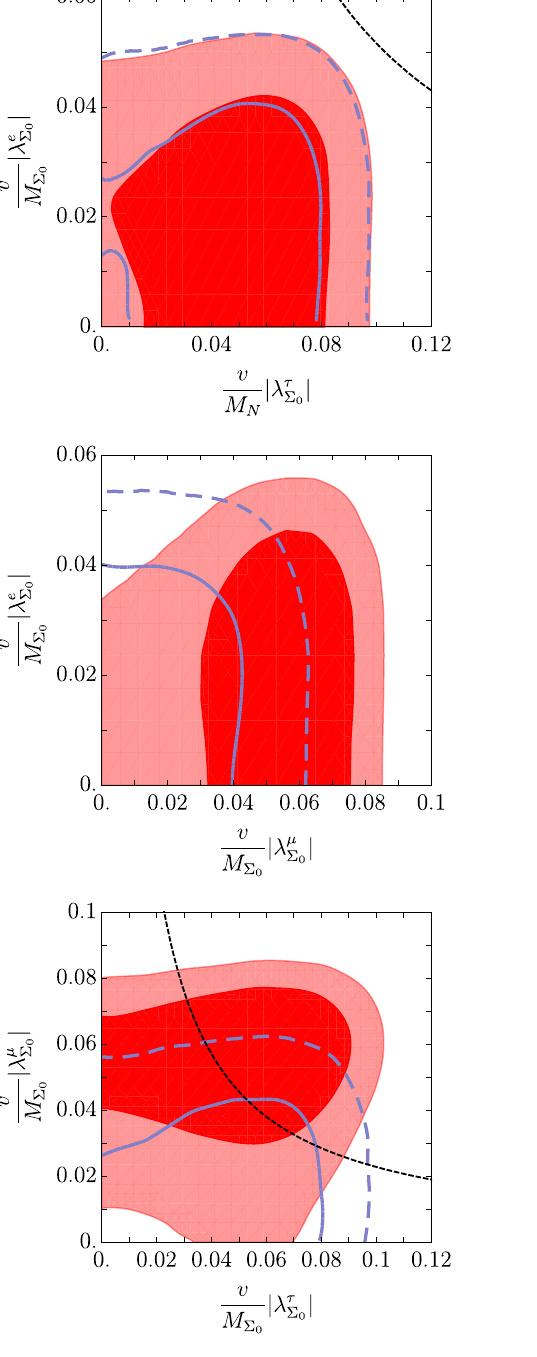
Figure 7 . Preferred regions for Σ 0 and Σ 1 . The color coding is the same as in figure 3 and the black line indicates the exclusion by τ → 3 µ or τ → 3 µ in case of one generation of VLLs. The exclusions from µ → e processes are very stringent and for better visibility shown in figure